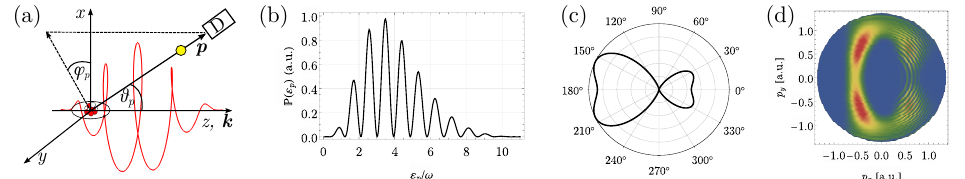
Figure 1. ATI experiment and typical observables. ( a ) geometry of an ATI experiment: An atom is irradiated by a strong laser pulse (red) of intensity I and wavelength λ that propagates along the z -axis and is polarized with ellipticity (cid:101) within the x y plane . Due to the interaction with the − laser field, a photoelectron is emitted with momentum p = ( p , ϑ p , ϕ p ) in spherical coordinates and measured at the detector D. ( b ) For a given position of the detector within the polarization plane, the measured photoelectron energy distributions exhibit several ATI peaks that are just spaced by the photon energy. ( c ) For a few-cycle driving laser pulse, the angular distribution of photoelectrons with fixed energy reveals an asymmetry which encodes details of the pulse structure and the electron continuum. ( d ) In addition, full photoelectron momentum distributions are often recorded within the polarization